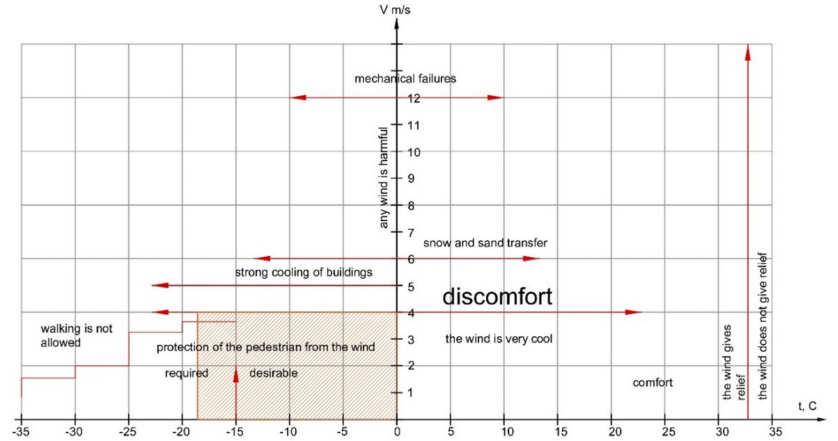
Figure 3. Climatic conditions for population for an average winter temperature of − 18 ◦ C in the Murmansk metropolitan area.